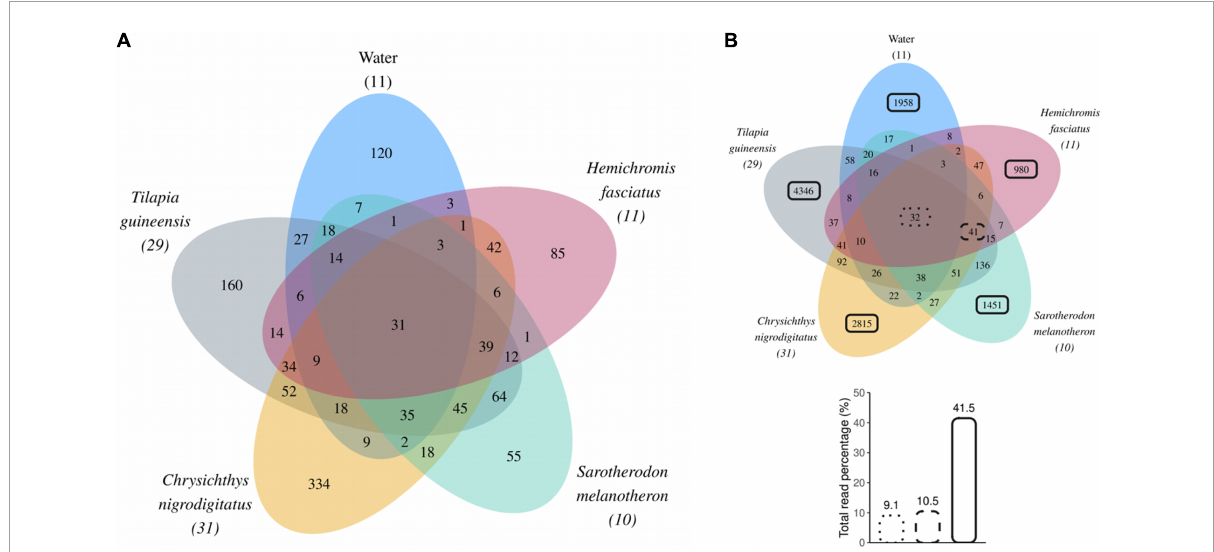
FIGURE5 (A) Venn diagram displaying Amplicon Sequence Variants (ASVs) abundant in at least one sample across water or fish guts. Numbers in brackets represent numbers of samples collected over the year for each sample type. (B) Venn diagram including all ASVs shared between water or fish gut samples. Black boxes (dotted, dashed, or solid lines) highlight ASVs for which the reads contribution was calculated and expressed as a percentage of total